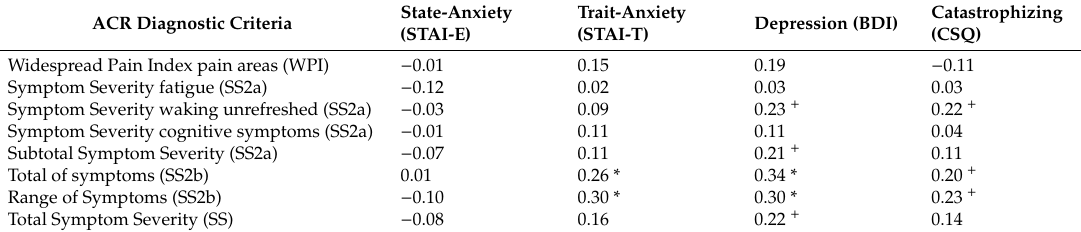
Table 5. Correlations of WPI and SS with anxiety, depression and catastrophizing in FMS ( n = 102). ACR Diagnostic